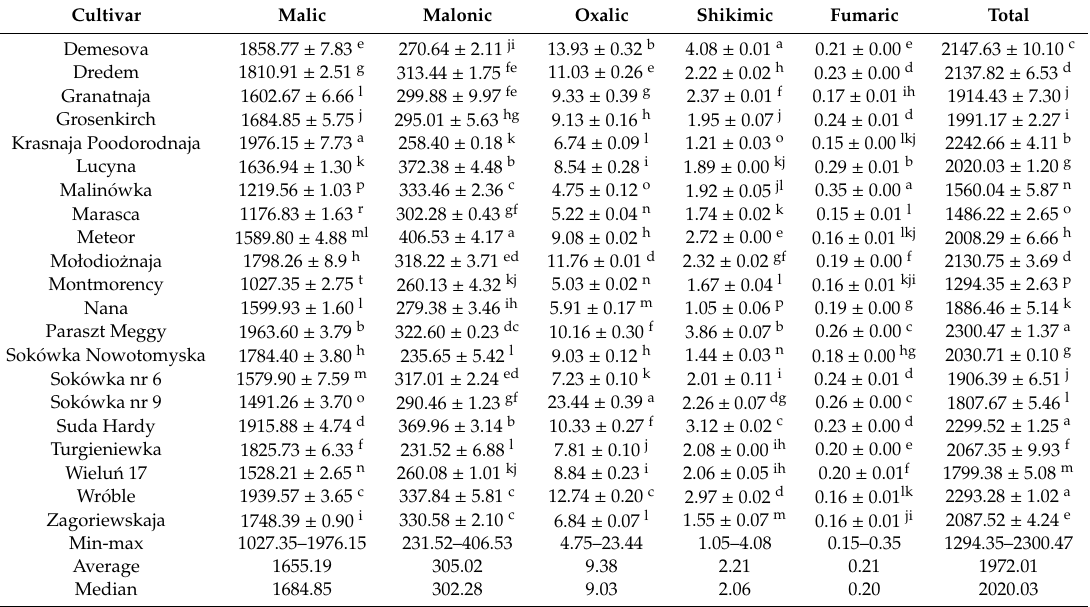
Table 2. Organic acids content (mg / 100 g FW) in sour cherry fruit of 21 cultivars.